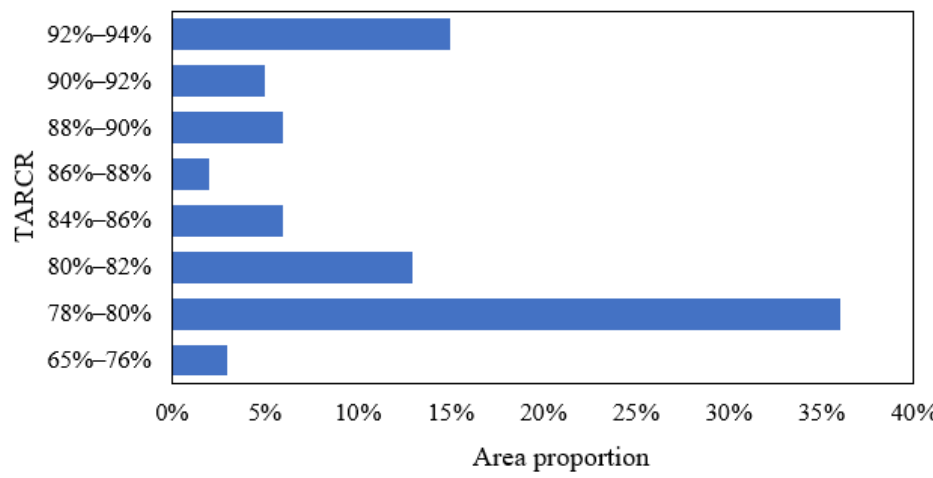
Figure 7. Percentages of area assigned the indicated ARVCRs.